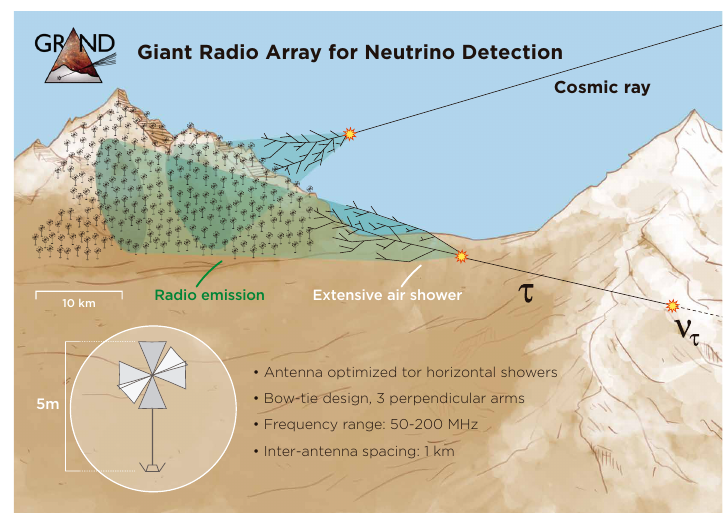
Figure 1. GRAND detection principle for cosmic rays or gammas (detection of the EAS induced by the direct interaction of the cosmic particles in the atmosphere) and neutrinos (underground interaction with subsequent decay of the tau lepton in the